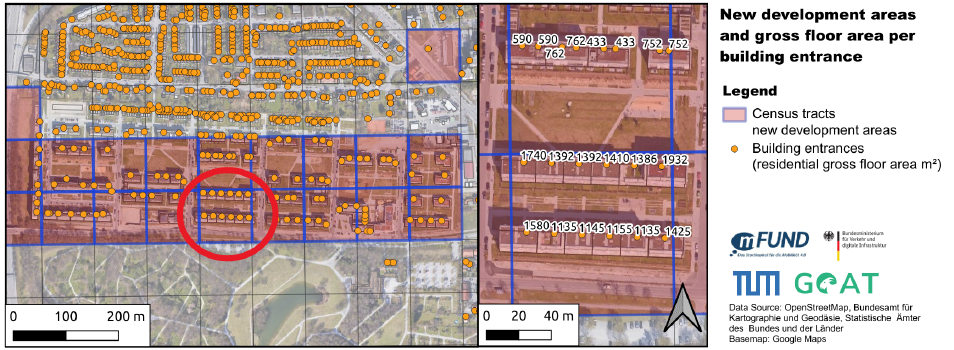
Figure 11. New development areas and gross floor area per building entrance.